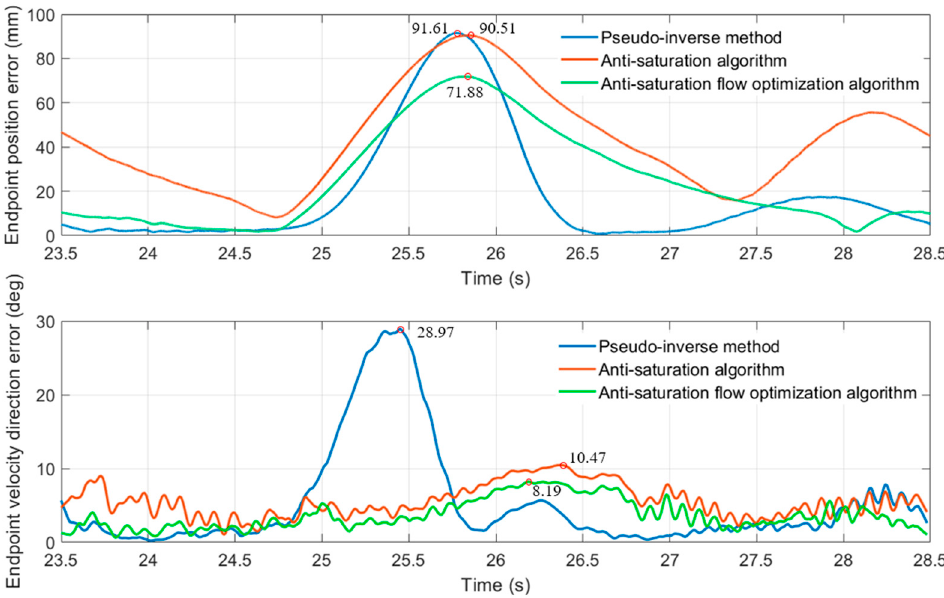
Figure 14. Comparison diagram of the position error and velocity direction error of the endpoint trajectories in the same stable period when flow saturation occurs.